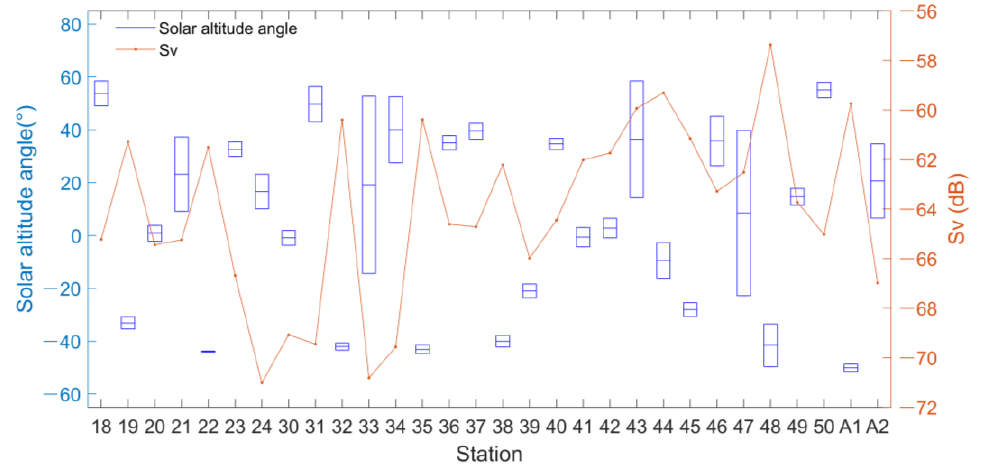
Figure 8. The scattering strength and solar altitude angle corresponding with the survey time of each station. The upper and lower boundaries of the box represent the maximum and minimum solar altitude angles, and the median line represents the median value.